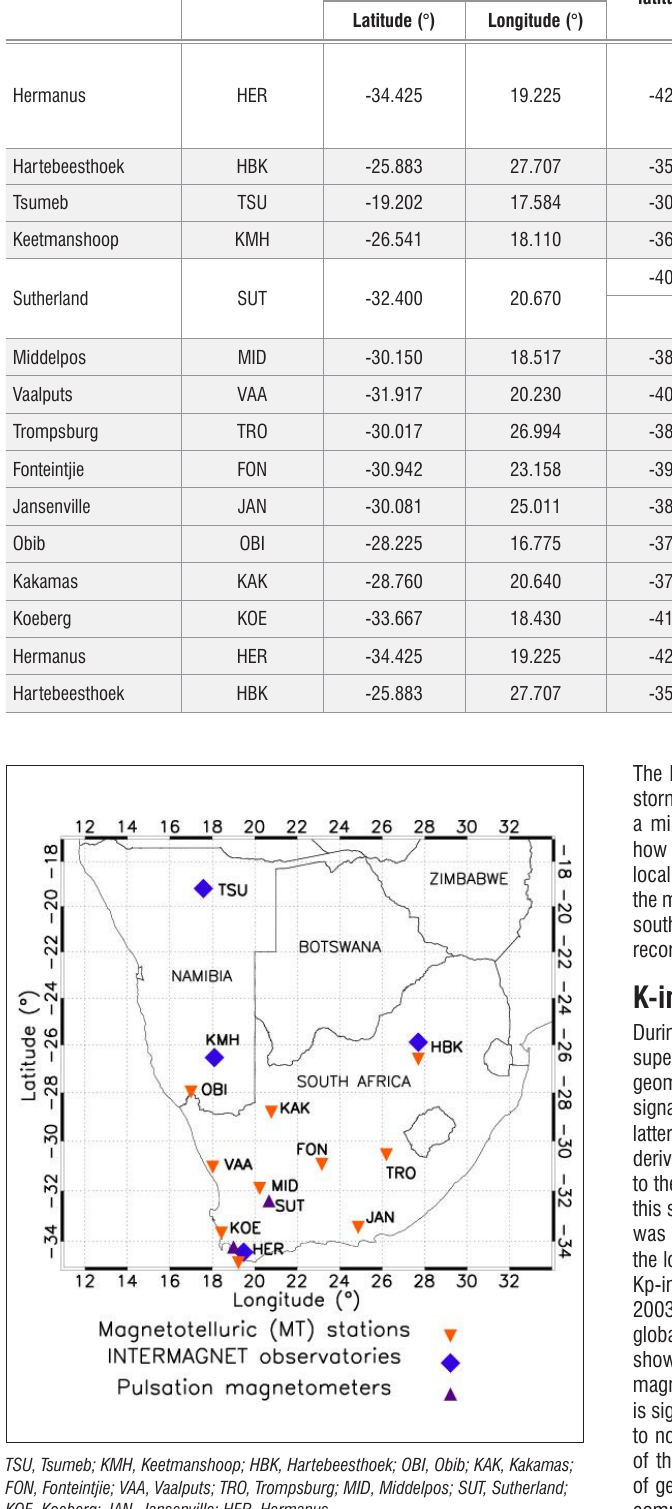
Figure 1: South African National Space Agency’s geomagnetic observation network over southern